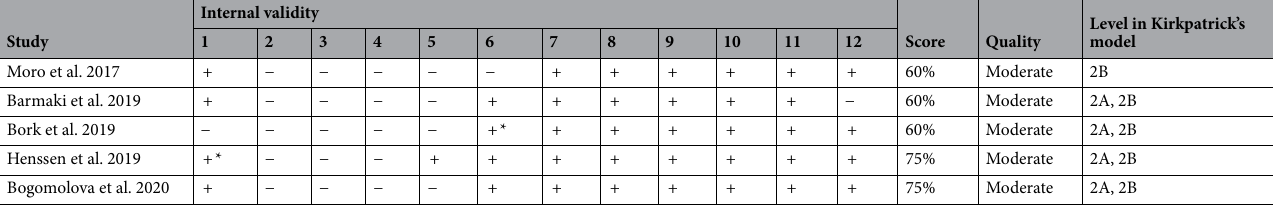
Table 1. Quality assessment of the evidence provided by the individual papers. 1. Was the method of randomization adequate? 2. Was the allocation concealed? 3. Was the participant blinded to the intervention? 4. Was the teacher blinded to the intervention? 5. Was the outcome assessor blinded to the intervention? 6. Was the dropout rate described and acceptable? 7. Were all randomized participants analyzed in the group to which they were allocated? 8. Are reports of the study free of suggestion of selective outcome reporting? 9. Were the groups similar at baseline regarding the most important prognostic indicators? 10. Were co-interventions avoided or similar? 11. Was the compliance acceptable in all groups? 12. Was the timing of the outcome assessment similar in all groups? + , criterion achieved; –, criterion not achieved; * , assessors initially disagreed. High: > 75% of the criteria have been fulfilled [≥ 10/12]. Where they have not been fulfilled the conclusions of the study or review are thought very unlikely to have been altered. Moderate: 50–75% of the criteria have been fulfilled [6–9/12]. Those criteria that have not been fulfilled or not adequately described are thought unlikely to have altered the conclusions. Low: Less than 50% of the checklist criteria were fulfilled [< 6/12]. The conclusions of the study are thought likely or very likely to alter had those criteria been fulfilled 54–63 . Levels of change of knowledge according to the model of Kirkpatrick: (1) reaction; (2A) learning (change in attitude); (2B) learning (modification of knowledge or skills; (3) behavior (change in behavior); (4A) results (change in the system/organizational practice); and (4B) results (improvement in learner performance) 20,21 . Printed below is the overview of the quality assessment as assessed by the second version of the Cochrane risk-of-bias tool for randomized trials (RoB 2).